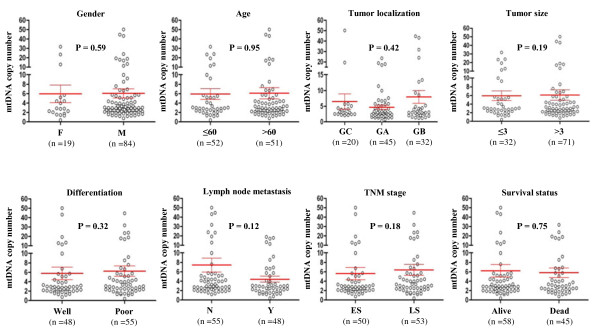
Association of mtDNA copy number with clinicopathological characteristics in gastric cancer. Copy number of mtDNA was analyzed using real-time quantitative PCR approach. The circle represents mtDNA copy number of each case of gastric cancers. Horizonal lines represent mean ± S.E. Sample means were compared using the Mann–Whitney U test. Details are as described in Methods. F, female; M, male; GC, gastric cardia; GA, gastric antrum; GB, gastric body; Well, well/moderate differentiation; Poor, poor/undifferentiation; N, non-lymph node metastasis; Y, lymph node metastasis; ES, early-stage; LS, late-stage.